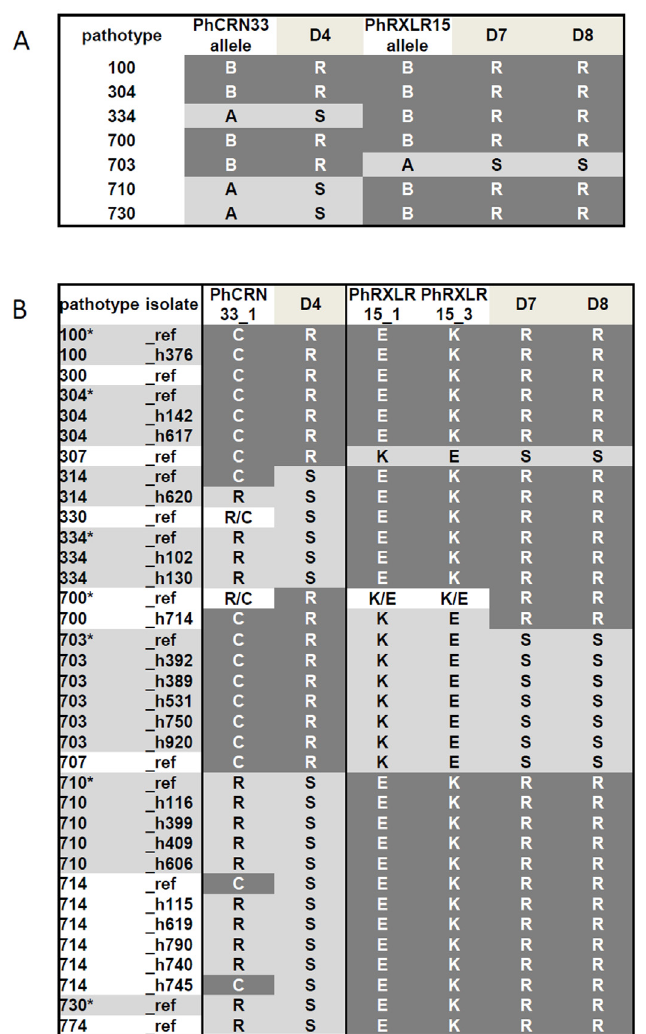
Fig 5. Putative associations between resistance (R) or susceptibility (S) profiles of sunflower lines (D4, D7 and D8) and genetic profiles of effector markers (PhCRN33 and PhRXLR15) in Pl . halstedii pathotypes from sequenced data (A) and from KASP marker results (B). (A) PhCRN33 and PhRXLR15 type B sequenced alleles from 7 pathotypes (100, 304, 334, 700, 703, 710 and 730) were respectively associated with resistance profiles of D4, D7, and D8 sunflower lines. (B) Respective associations of PhCRN33_1 and PhRXLR15_1-PhRXLR15_3 observed polymorphisms in 35 Pl . halstedii isolates with resistance (R) profiles of D4, D7, and D8 sunflower lines. The amino acids of the corresponding translated sequences are indicated for each SNP position.